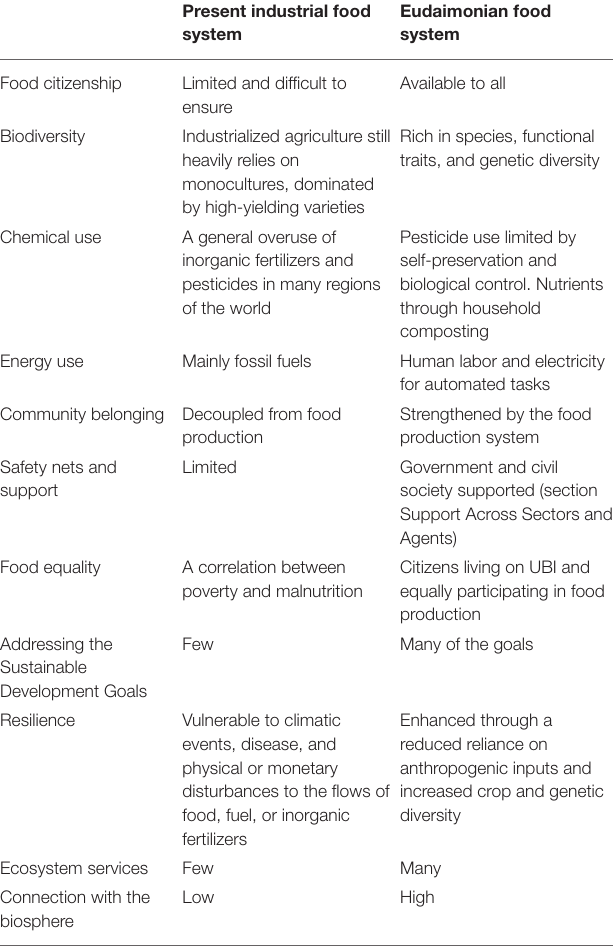
TABLE 1 | Characteristics of the industrial and the Eudaimonian food systems. Present industrial food